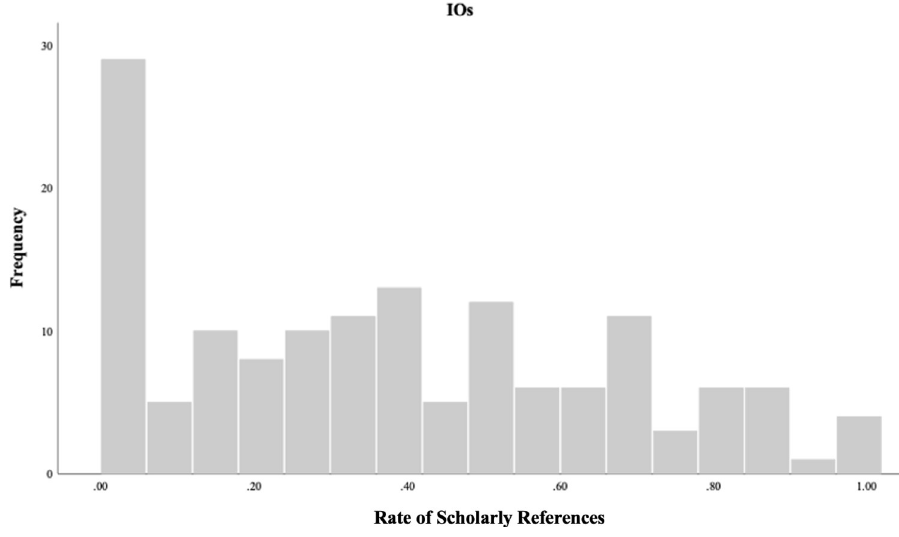
Fig 3. Distribution of scholarly references by